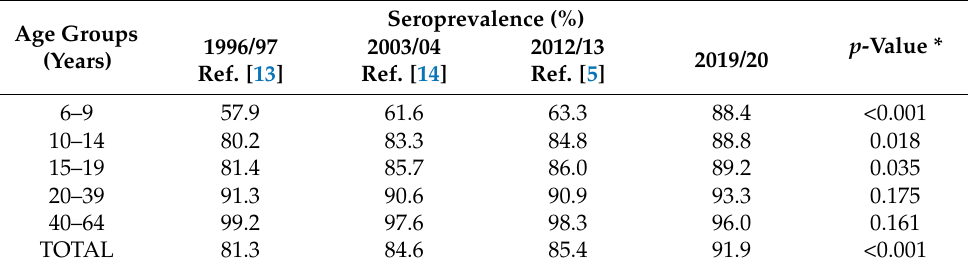
Table 5. Comparison of seroprevalence recorded in different studies conducted in